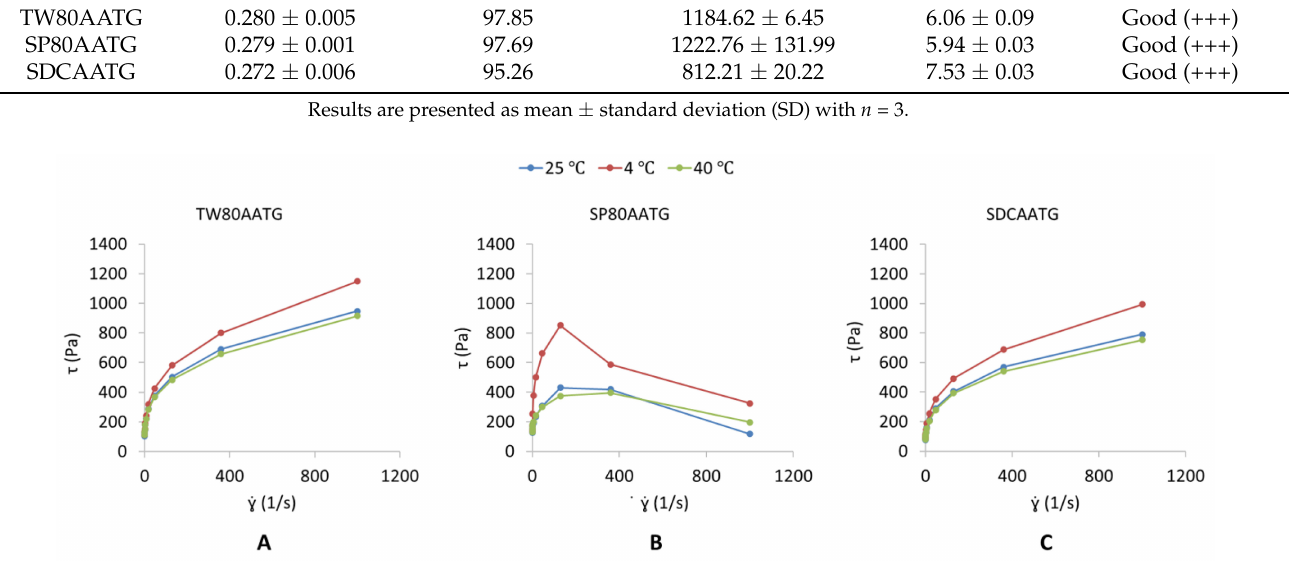
Figure 1. Shear stress [ τ ] (Pa) versus shear rate [ ɣ̇ ] (s − 1 ) profile of ( A ) TW80AATG, ( B ) SP80AATG and ( C )